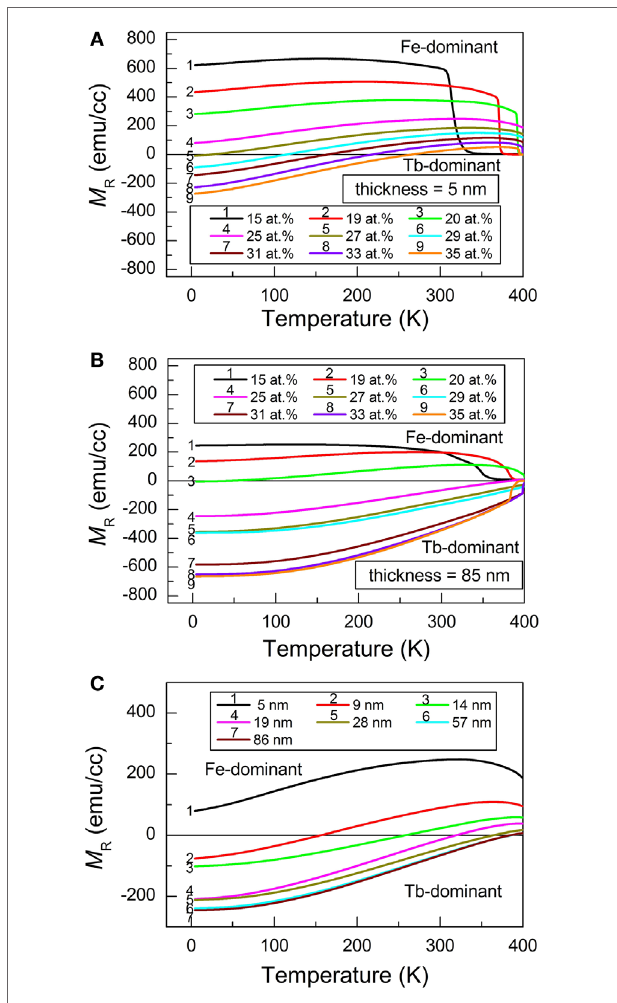
FigUre 3 | remanent sample magnetization M r versus temperature for (a) a 5-nm and (B) a 85-nm-thick Tb x Fe 100 − x film . (c) The remanent magnetization of the Tb 25 Fe 75 film shifts from the Fe to the Tb dominated site with increasing film